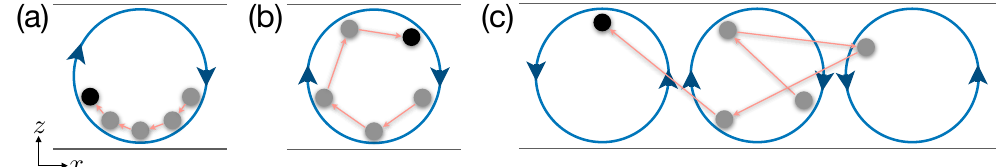
Figure 4. Schematic illustration of the motion of a tagged particle for different coarse-graining times τ . ( a ) Shorter τ . ( b ) Intermediate τ . ( c ) Longer τ